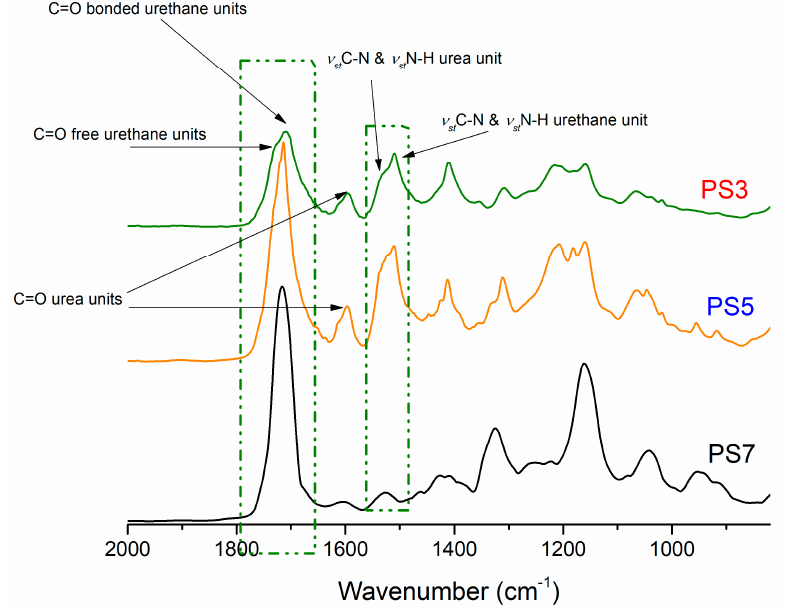
Figure 6. FTIR spectra of polyurethane foams: PS3, PS5 and PS7.